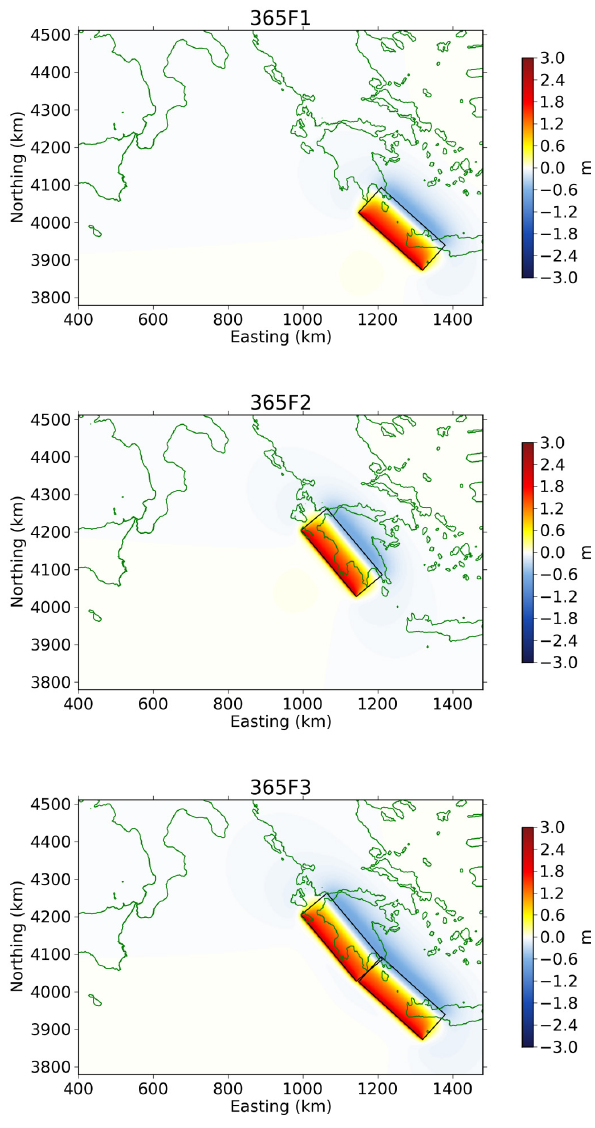
Fig. 2. Initial condition for the three source model hypotheses based on the 365 AD earthquake. The initial conditions correspond to the co-seismic vertical displacement of the